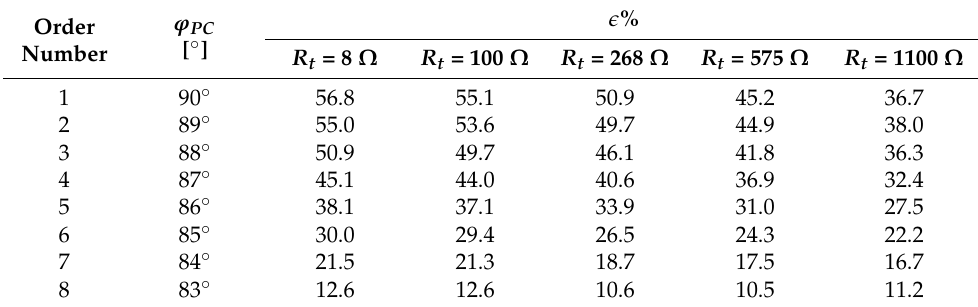
Table 13. The difference between the effective values of the fault current determined experimentally and analytically ( ϕ c = 90 ◦